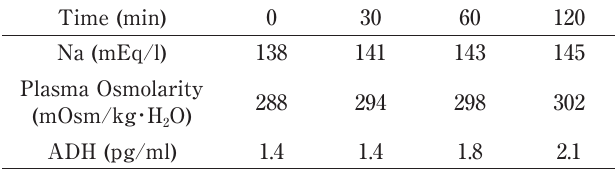
Table 2. Hypertonic saline solution challenge